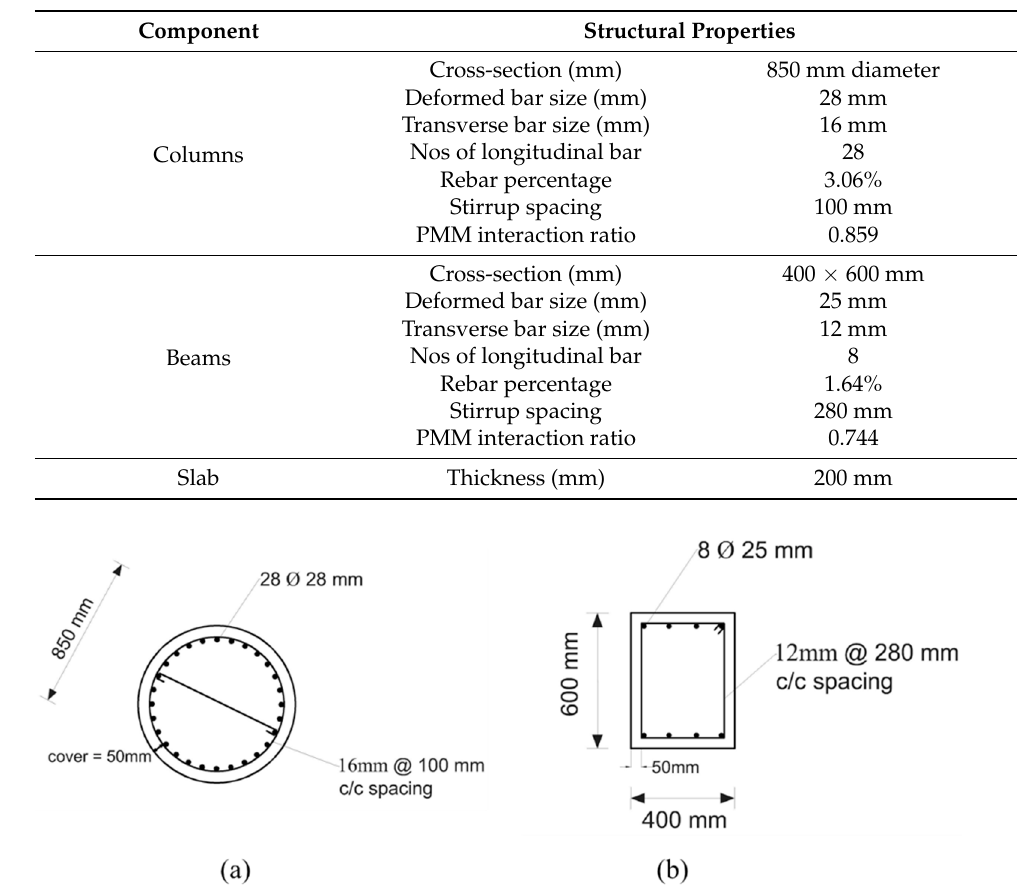
Figure 3. Detailed properties of ( a ) column and ( b ) beam. Table 1. Structural properties of the building.